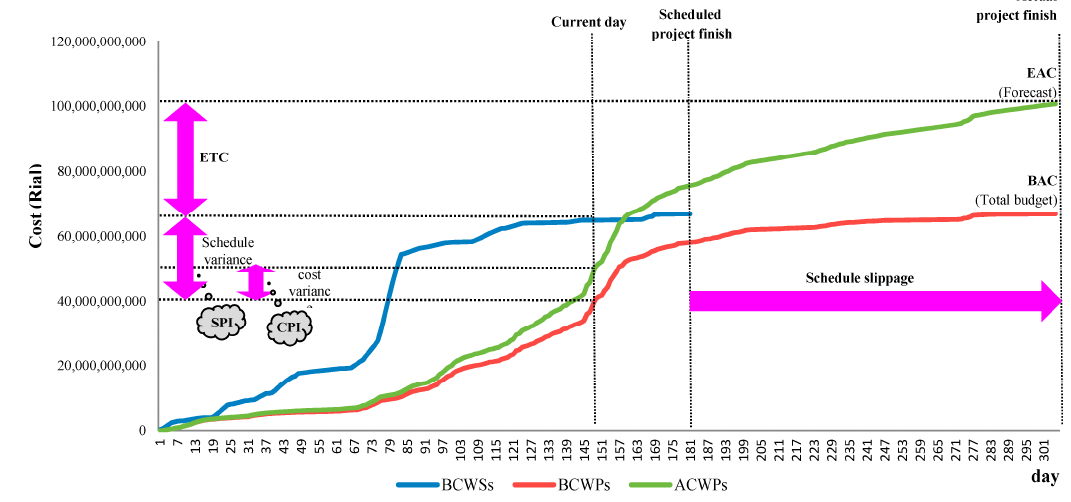
Figure 20. Simulation results for the given project. EAC, Estimate At Completion; BAC, Budget At Completion; SPI, Schedule Performance Index; CPI, Cost Performance Index.